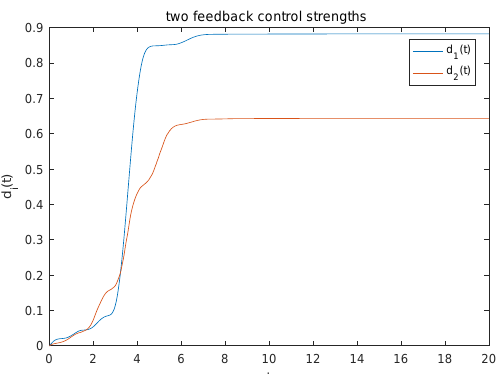
Figure 5. Adaptive update effects of two feedback control